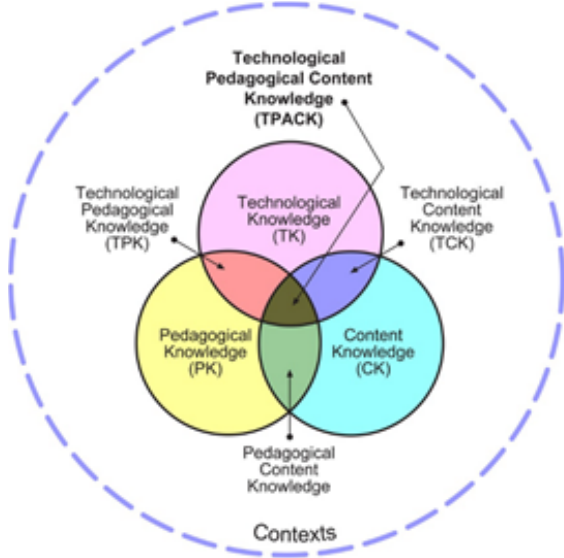
Figure 3. The TPACK framework according to [15] (pp.